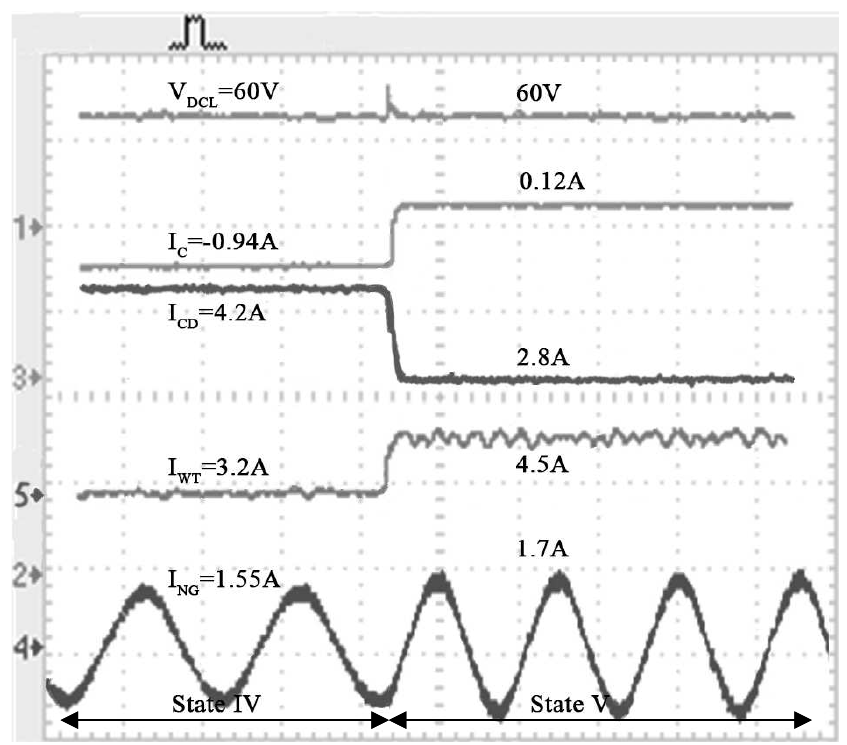
Figure 30. Experimental result for states IV and